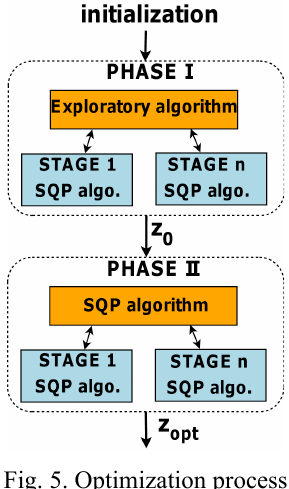
Fig. 5. Optimization process